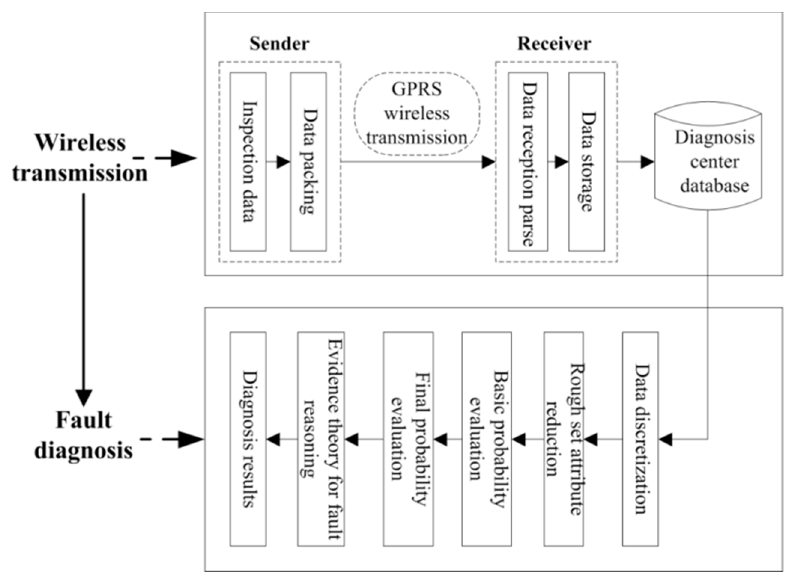
Figure 4. IoT network layer structure.